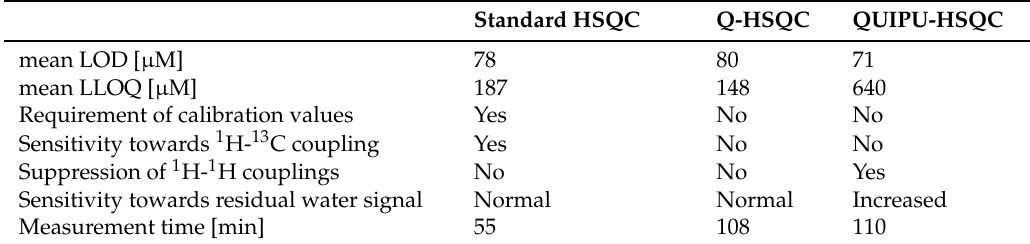
Table 2. Summary of the properties of Standard HSQC, Q-HSQC and QUIPU-HSQC. LODs and LLOQs were calculated from the results in Tables S3–S5. The LOD is defined as the minimum concentration above which a compound is always detected. The LLOQ is defined according to FDA guideline as the minimum concentration for which the RSD is < 20%.